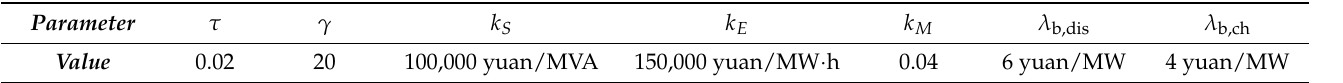
Table 3. Energy-intensive load parameters.